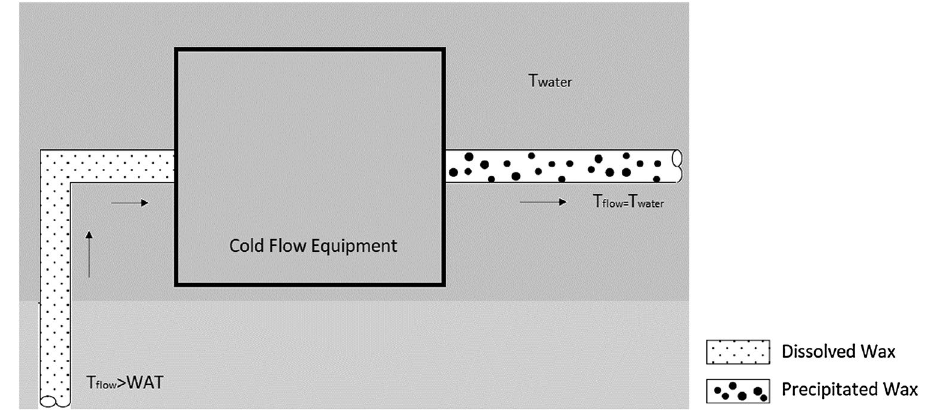
Fig. 4 Schematic representation of a cold flow